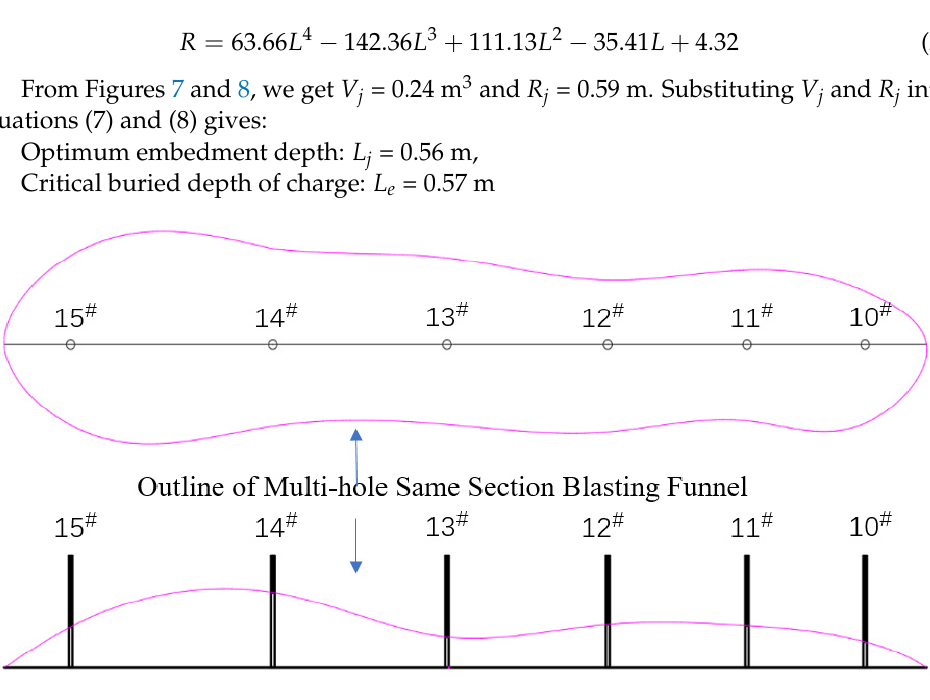
Figure 7. R-L funnel radius and explosive package burial depth relationship curve. According to the principle of the least square method, the test data of the blasting funnel are regressed for four times, and the volume of the blasting funnel ( V j ) and the buried depth of the explosive charge ( L e ) are obtained. The multiple expressions between the radius of blasting funnel ( R j ) and the buried depth of explosive charge ( L j ) are as follows: